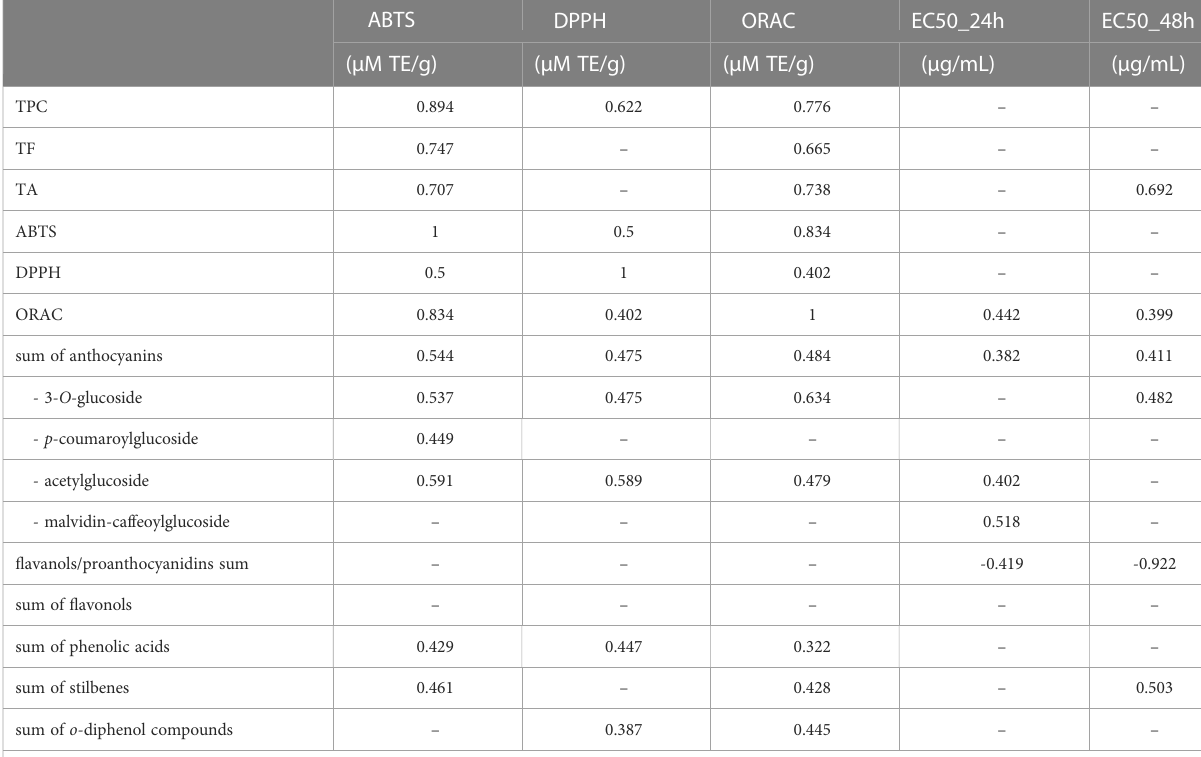
TABLE 3 Pearson ’ s correlation coef fi cients of total phenolic content (TPC), total anthocyanins (TA) and total fl avonoids (TF), phenolic compound groups (anthocyanins, fl avanol/proanthocyanidins, fl avonols, phenolic acids, and stilbenes), antioxidant activity (ABTS, DPPH, ORAC) and median concentration of antiproliferative activity (EC50 after 24h and EC50 after